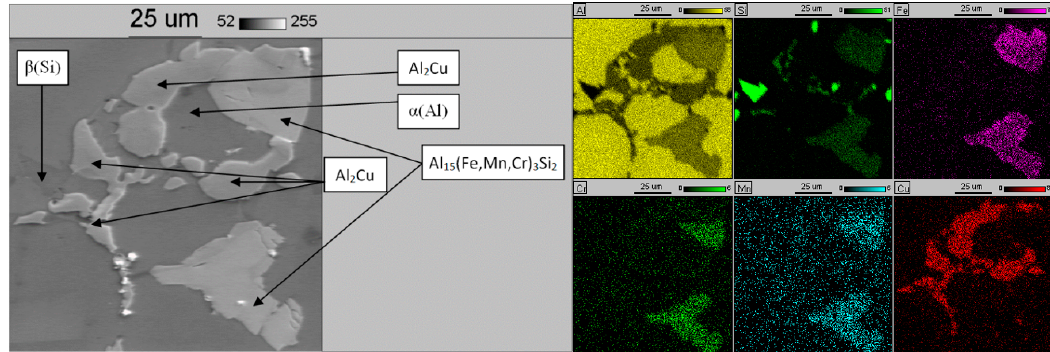
Figure 12. An example of the quaternary eutectic region of Al-Si alloy containing 0.4 wt % and the map of Al, Si, Fe, Cr, Mn, and Cu distribution.